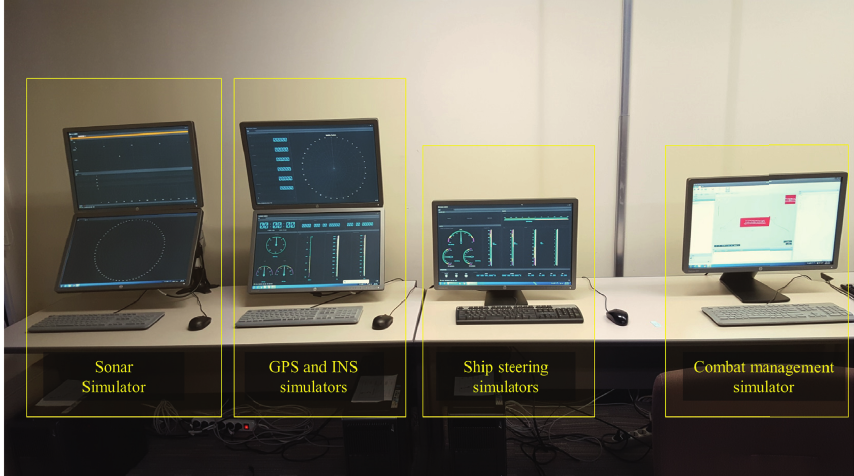
Figure 6: Simulation architecture of combat management simulator.